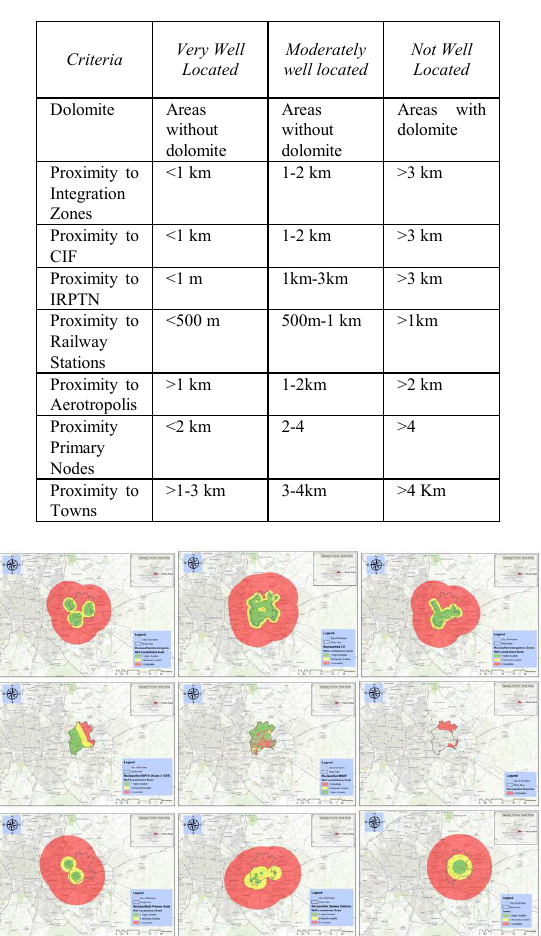
Figure 3: Suitability Criteria Maps (1. Aerotropolis proximity; 2. Capital Investment Framework proximity; 3.